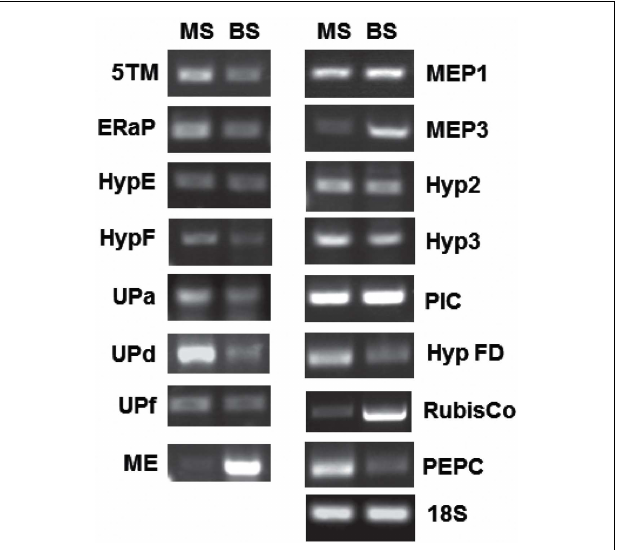
FIGURE 3 | RT-PCR showing relative abundance of transcripts for several genes encoding chloroplast envelope proteins. Band intensities of three to five biological replicates were quantified and are displayed in Table 2 . MS, mesophyll; BS, bundle sheath.